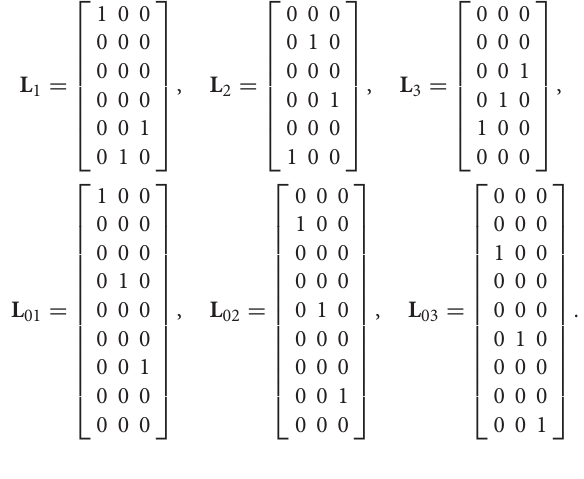
The band diagram in terms of wavenumber k and energy velocity c e for the undeformed unit cell of Figure 2 at ϑ = 0 is reported in Figure A1 .